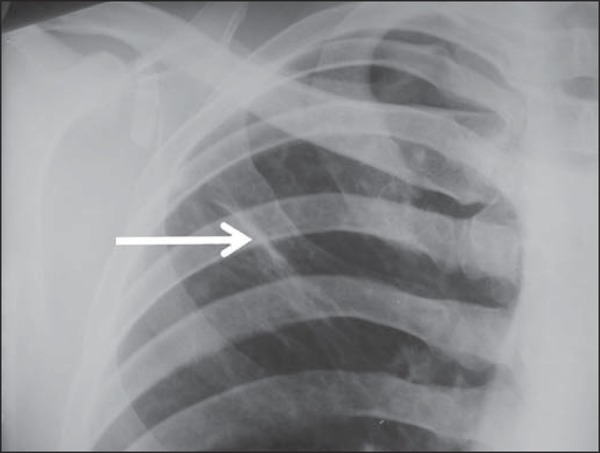
A 32-year-old man with linear density in the right lung apex (arrow). This
radiographic image was acquired two years after a successful treatment for
pulmonary tuberculosis.